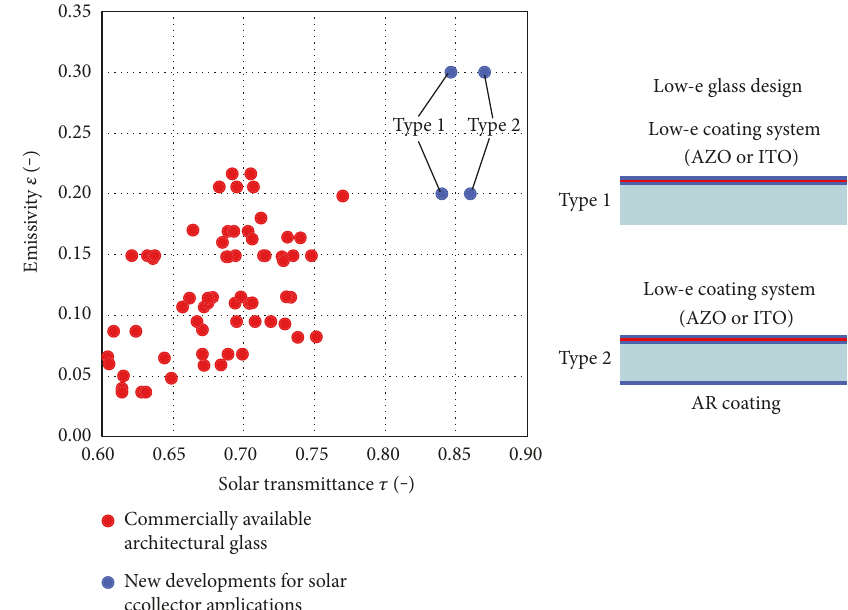
Figure 2: Optical properties of spectrally selective glass with high solar transmittance for architecture and solar collector applications [18].